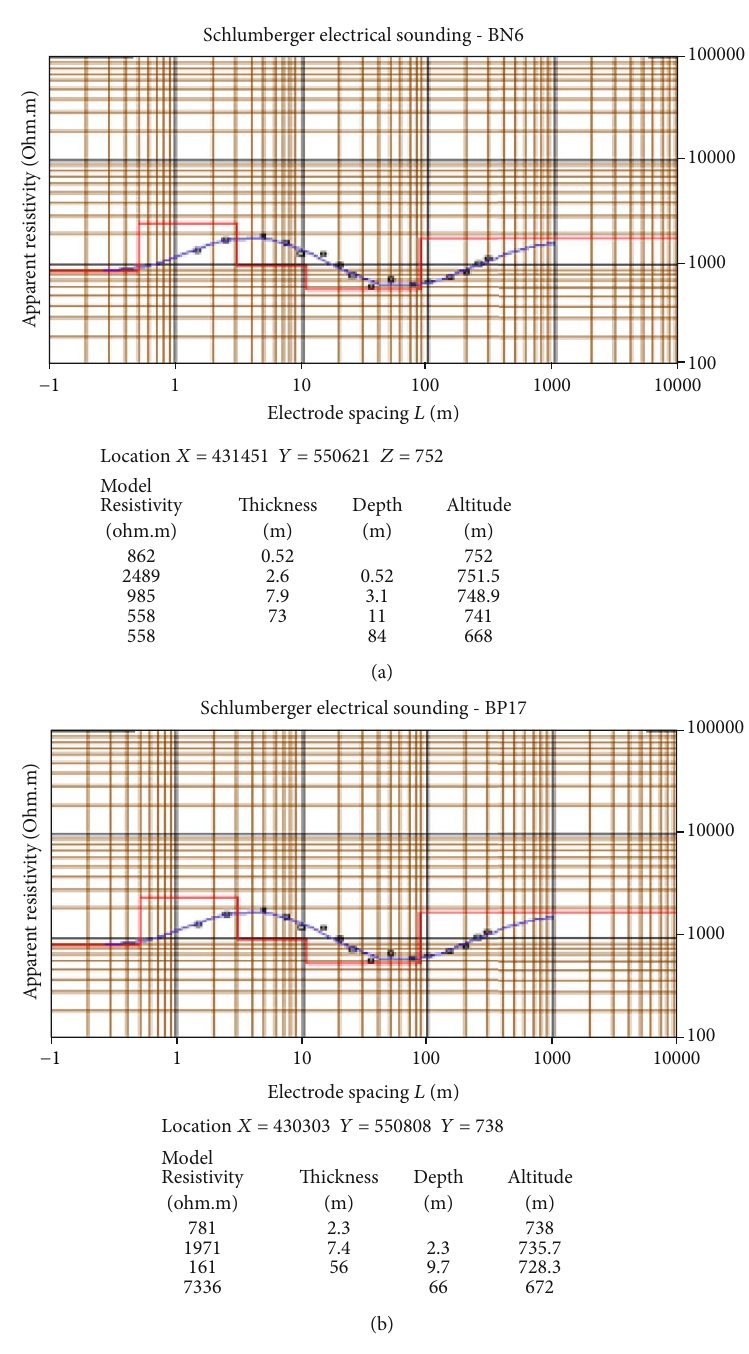
Figure 10: (a, b) Sounding curves (BN